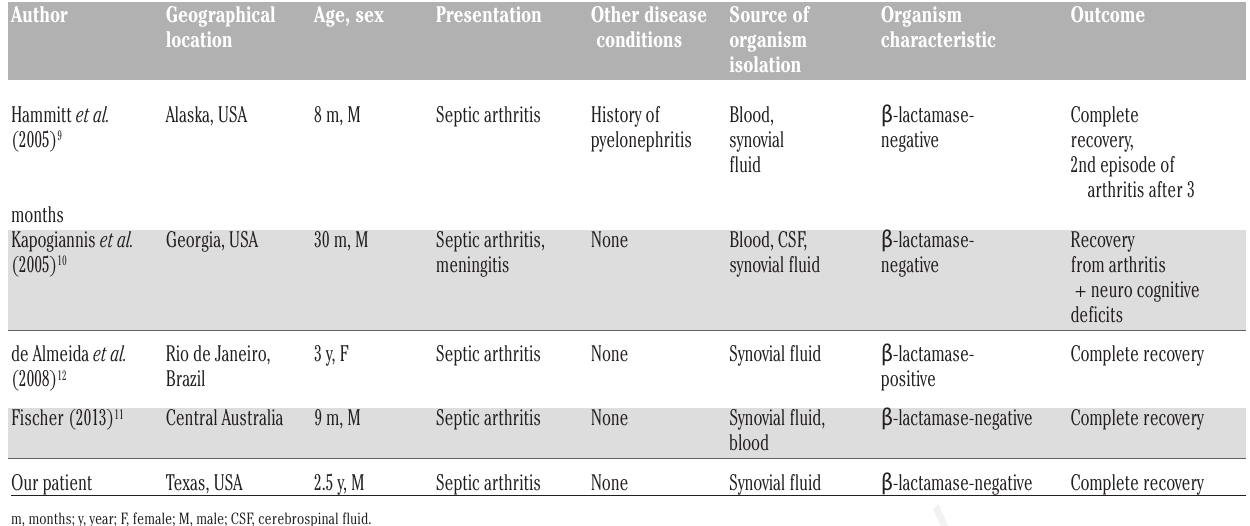
Table 1. Haemophilus influenzae A septic arthritis in